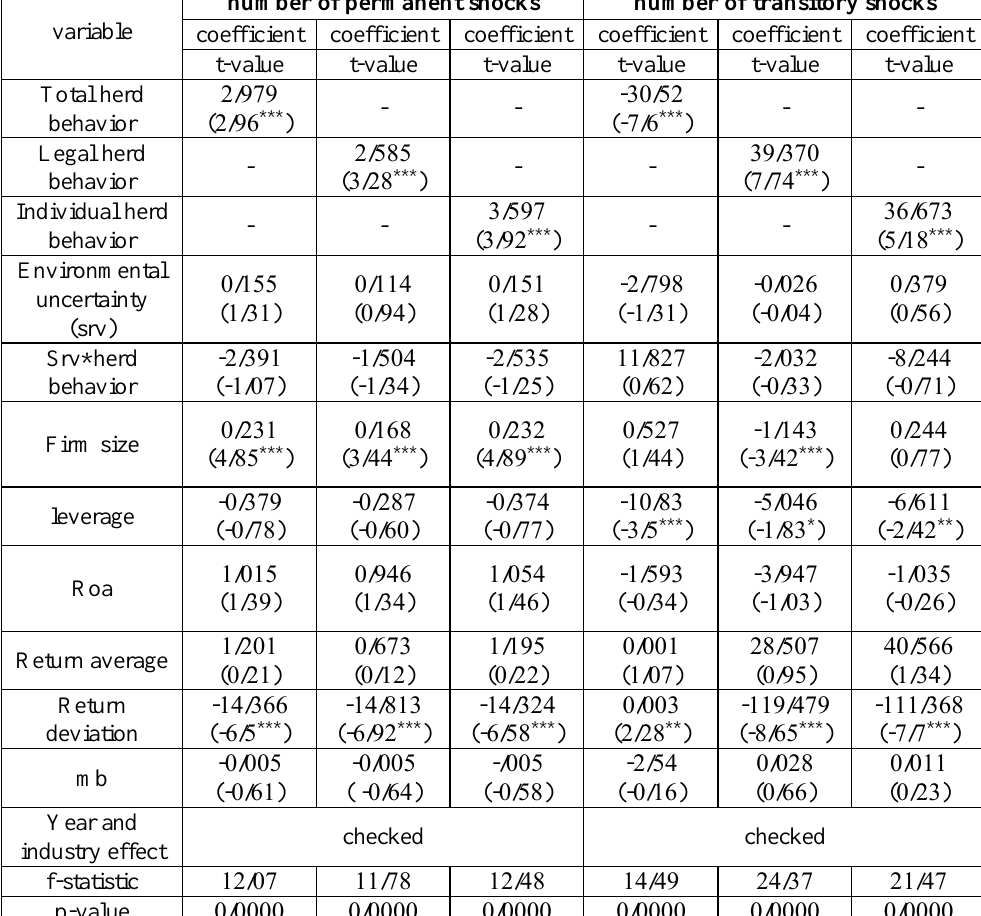
Table 5. effect of environmental uncertainty on the relationship between herd behavior (total, legal, individual) and the number of permanent and transitory